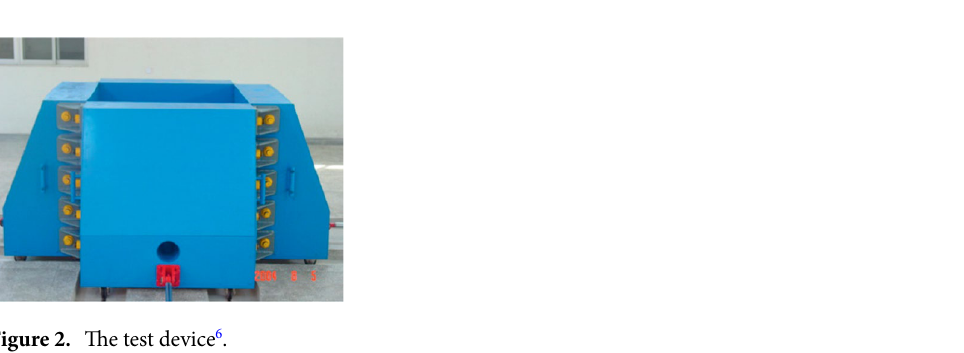
Figure 1. Cave rock mass fracture.